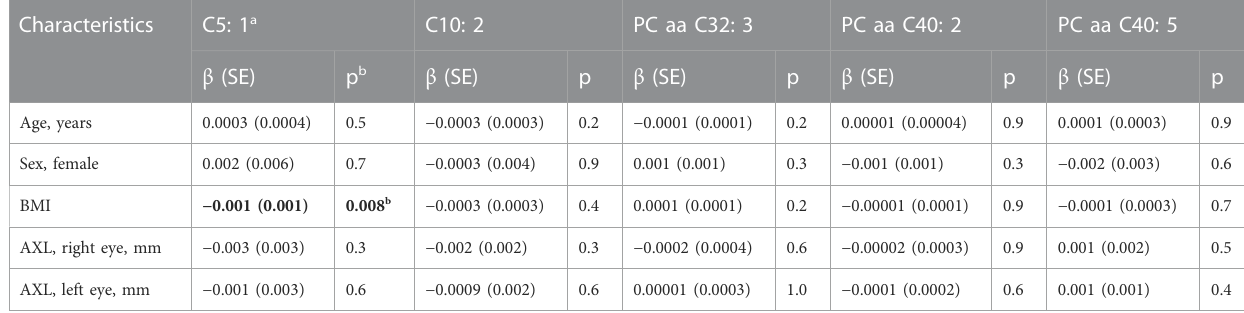
TABLE 4 Effect of age, sex, BMI, and AXL on interocular differences (right eye – left eye) on selected metabolites.